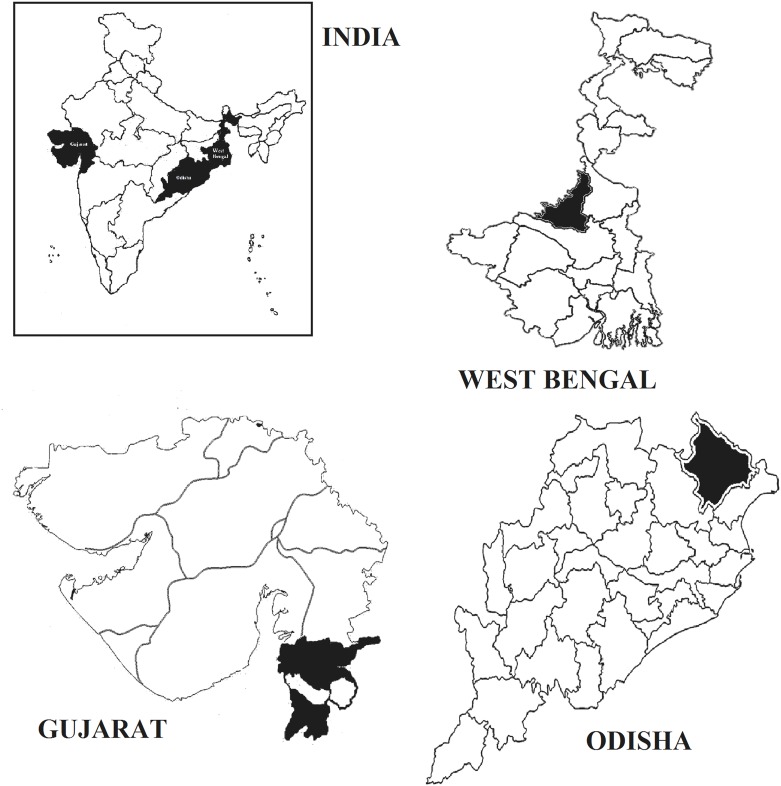
Geographic locations of the selected districts in West Bengal, Odisha, and Gujarat on the map of India.